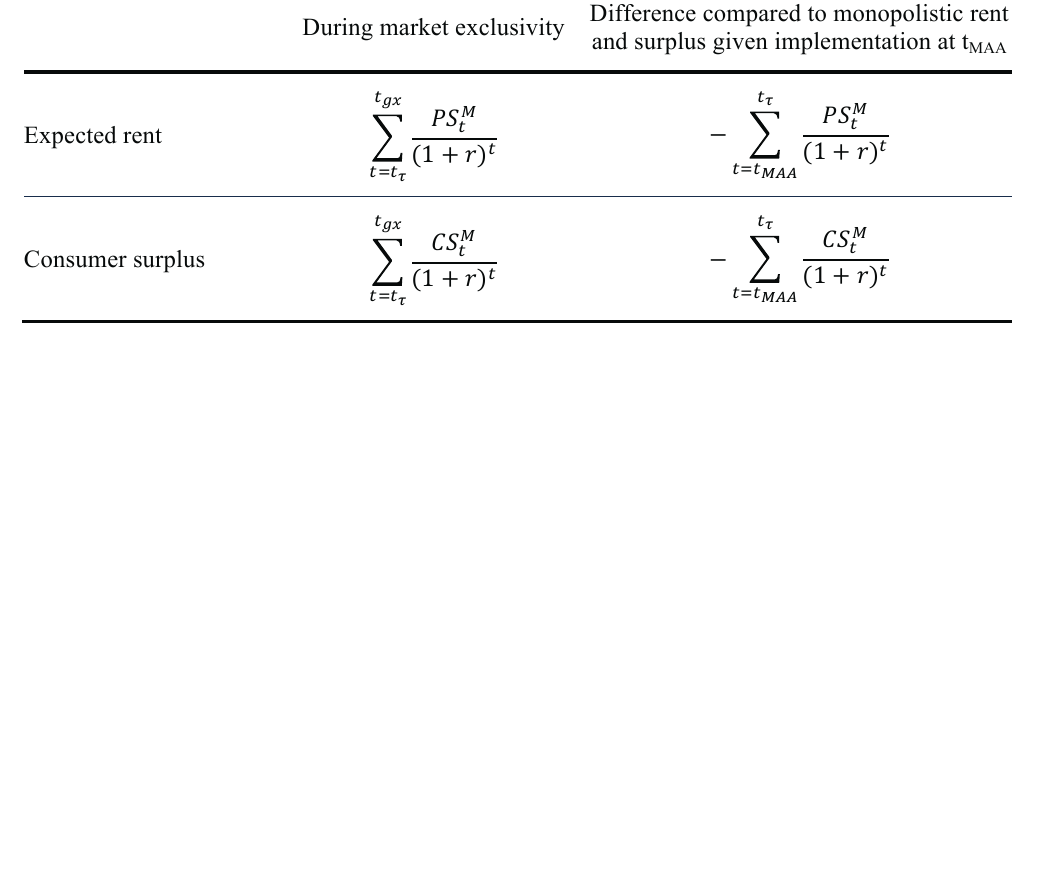
Table A1: Expected rent and consumer surplus during the time of patent protection given postponed implementation decision at time t τ Difference compared to monopolistic rent During market exclusivity and surplus given implementation at t MAA